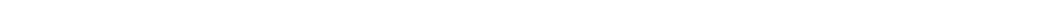
(see fi gure on previous page) Fig. 3 HG induces cardiomyocyte hypertrophy with abnormalities in mitochondrial dynamics and calcium handling. A WGA staining (red) of the surface membrane of cardiomyocytes, and DAPI staining (blue) of nuclei. Scale bars = 50 μ m. To quantify cardiomyocyte size, HG induced an increase in cardiomyocyte size ( n = 45 cells). B Western blotting images and summarized data showing β -MHC ( n = 5) and ANP (n = 11) levels in NRCMs. C Confocal images of mitochondrial morphology in NRCMs. RGB color, scale bars = 50 μ m; 8-bit color, scale bars = 3 μ m. There was a main effect of HG on the number of individuals and networks, and the size of the mitochondrial footprint. Overall, HG decreased all mitochondrial network parameters ( n = 140 cells). D JC-1 staining of NRCMs. Red fl uorescence is from JC-1 aggregates in healthy mitochondria with polarized inner mitochondrial membranes, while green fl uorescence is emitted by cytosolic JC-1 monomers and indicates MMP dissipation. Merged images indicate the co-localization of JC-1 aggregates and monomers. Scale bar = 50 μ m. MMP of cardiomyocytes for each group was calculated as the fl uorescence ratio of red to green. HG decreased the MMP ( n = 390 cells). E Western blotting images and summarized data showing Drp1 protein level and phosphorylation at S616 ( n = 6) or S637 ( n = 8) in NRCMs. F Western blotting images and summarized data showing Opa1 ( n = 4) and Mfn2 ( n = 3) protein levels in NRCMs. G Western blotting images and summarized data showing Orai1 protein levels in NRCMs ( n = 4). H Representative traces of Ca 2 + in fl ux in NRCMs are shown. Fluorescence intensity measurements of Fluo4-AM revealed the intracellular Ca 2 + concentration in NRCMs following CaCl 2 stimulation ( n = 76 cells). F 1 fl uorescence intensity, F 0 baseline fl uorescence. Data are shown as mean ± SEM. * P < 0.05, ** P < 0.01, and *** P < 0.001; n.s. no signi fi cant statistical